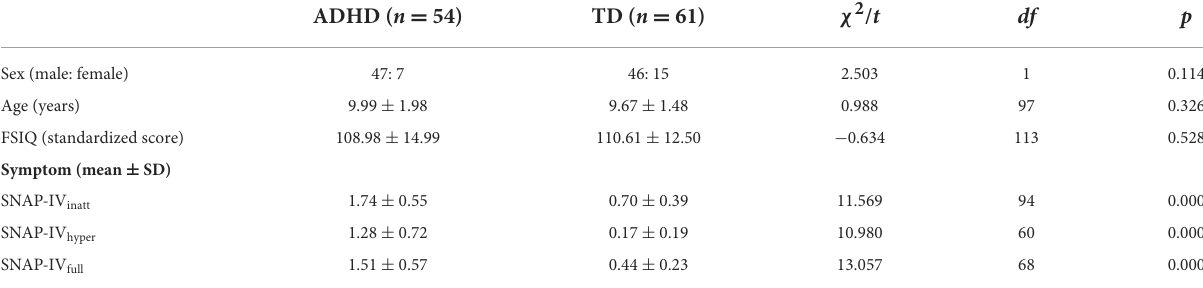
TABLE 1 Participant